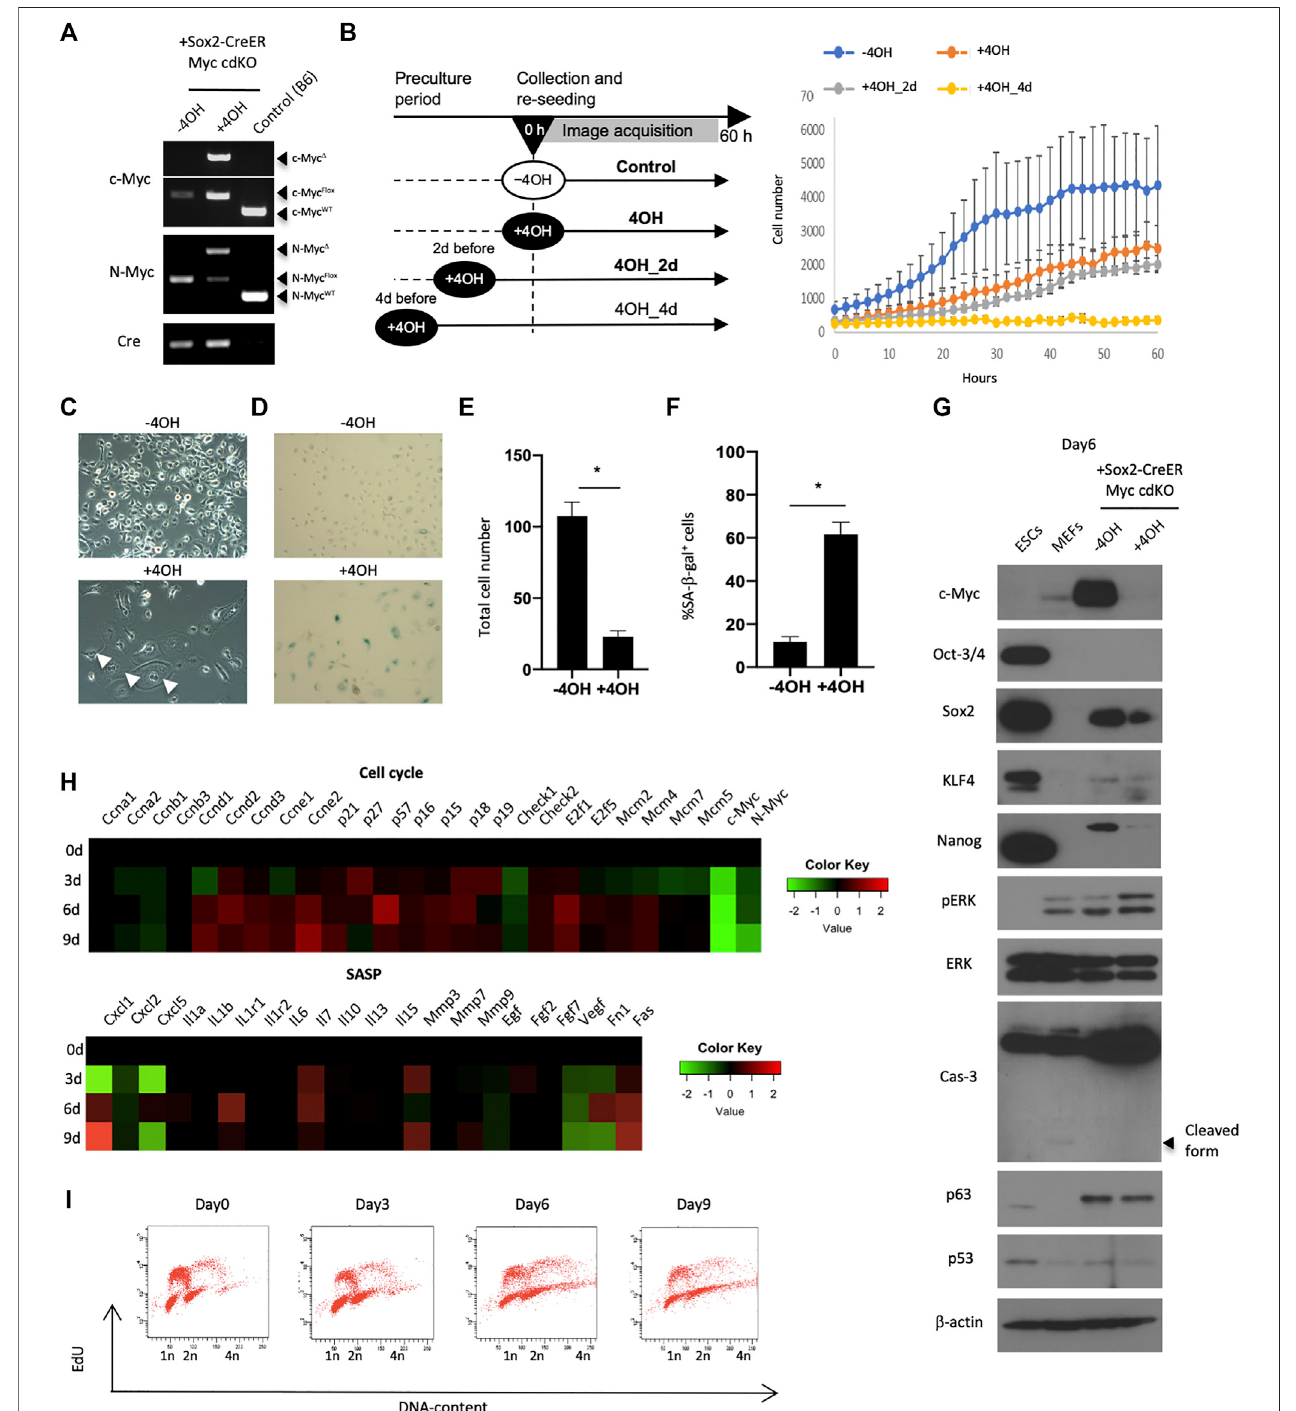
FIGURE 3 | Requirement of Myc for preserving self-renewal of esophageal epithelial cells. (A) Genotyping to con fi rm Myc knockout. The cells were treated with 0.1 μ M4OHfor3 daysand lysedforgenomic DNApuri fi cation.PCRreactions wereperformedusing puri fi edgenomic DNAforWT,Floxanddeleted ( Δ )allelesofc-myc and N-Myc. (B) Live-imaging of Myc cdKO mEPCs. Left, image acquisition scheme. Right, image-based cell count. (C) Image of untreated and the Myc cdKO mEPCs treated with 4OH for 9 days. White arrow indicates multinuclear cells. (D) SA- β gal staining in Myc cdKO mEPCs treated with 4OH for 9 days. Data represent the meanwithSE( n =6).* p < 0.0001. (E) Quanti fi cationoftotalcellnumberin (D) .DatarepresentthemeanwithSE( n =6).* p < 0.0001. (F) Quanti fi cationofSA- β gal-positive cells in (D) . Data represent the mean with SE ( n = 6). * p < 0.0001. (G) Western blotting for Myc cdKO mEPCs treated with 4OH for 6 days. (H) Nanostring-based gene expression analysis. Myc cdKO mEPCs were treated with 4OH and samples were collected at the indicated time-points. RNAs were isolated and subjected to Nanostring RNA detection. (I) Cell cycle analysis of Myc cdKO mEPCs by FACS.